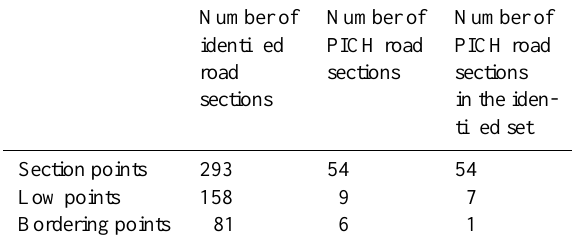
Table 1. Identification of the potentially flooded points in the calibration and validation windows.